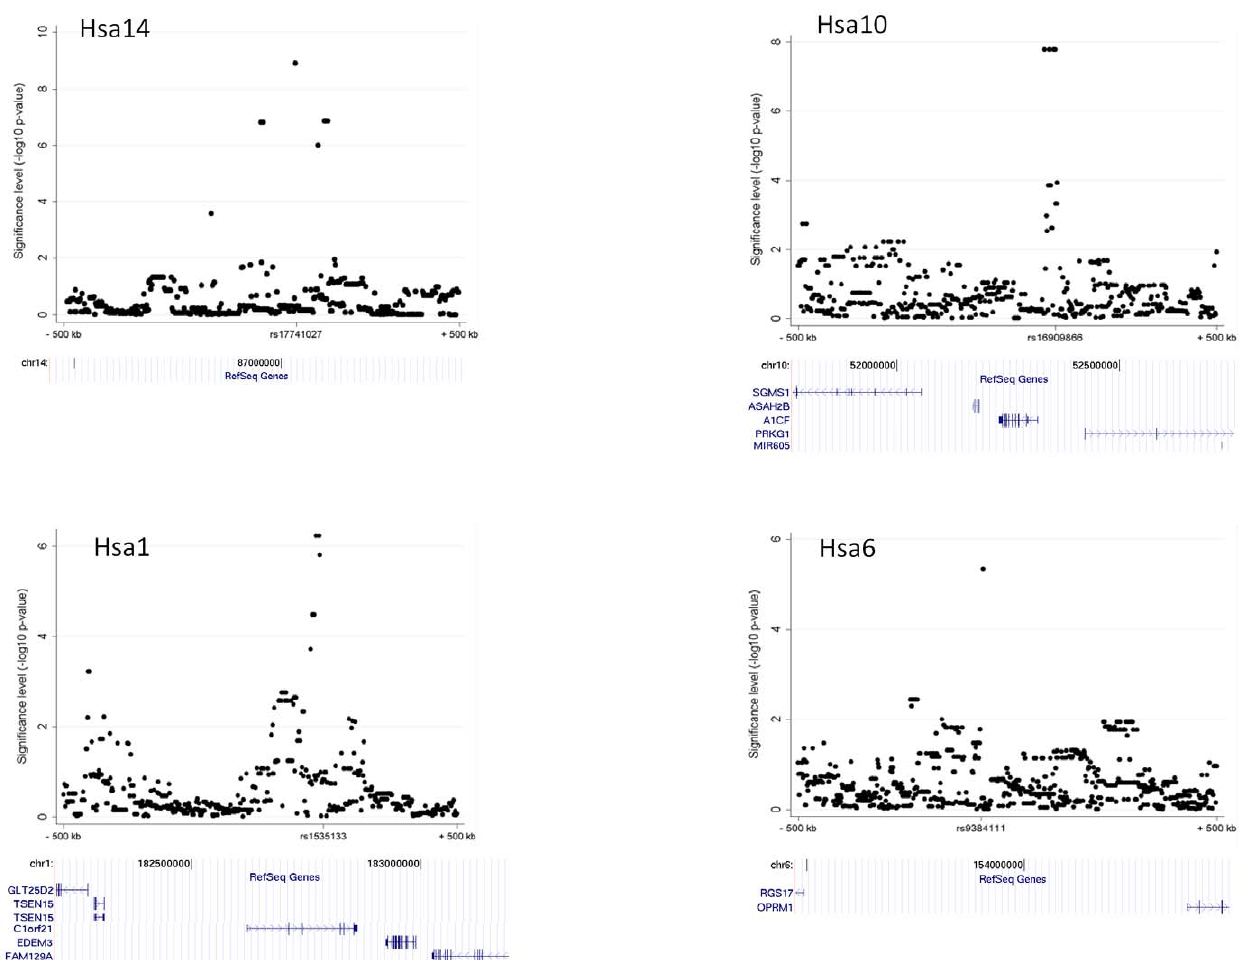
Figure 4. Examples of significant association findings in KORA-GenCord GWA. The significance level ( 2 log 10 P) of the top two association findings and two examples of top hits overlapping with either linkage, top GWA in HapMap, overlap with known candidate genes, or top findings on Hsa21 are shown within a genetic region of 1 Mb ( 6 500 kb around the significantly associated SNP). The chromosome, SNP ID, location and genic context (RefSeq genes, using UCSC genome browser) are indicated for each depicted